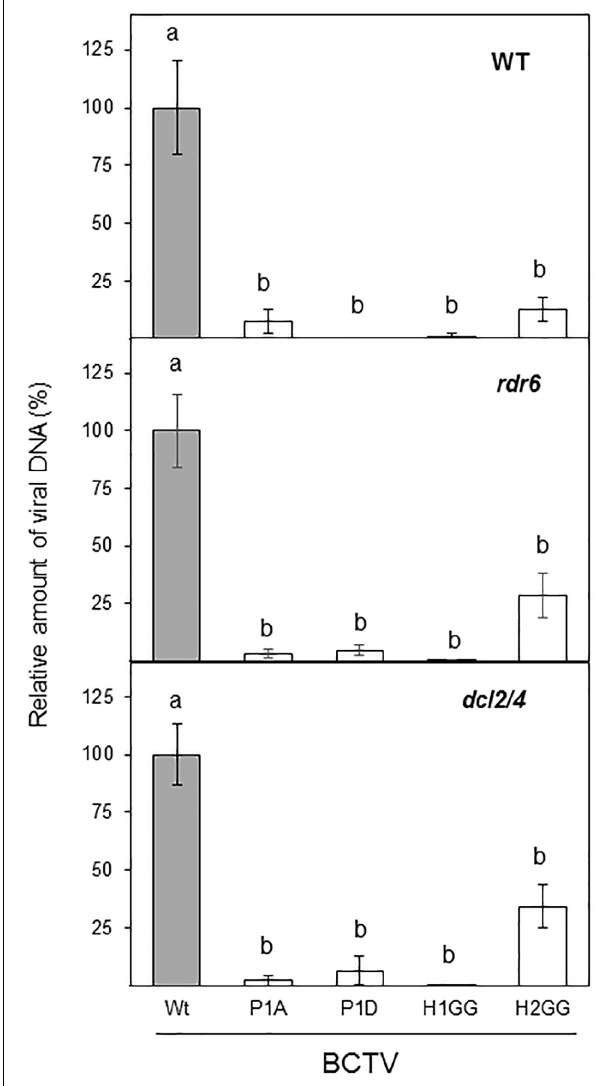
FIGURE 7 | Infection of A. thaliana wild-type (WT), dcl2/4 ( dcl2-1/dcl4-2 ) and rdr6 (rdr6-15) mutants with wild-type or BCTV V2 mutants. The relative viral DNA accumulation at 28 dpi was quantified by qPCR in WT, rdr6 and dcl2/4 backgrounds. DNA levels were normalized to actin gene and are presented as the relative amount of virus compared with the amount found in wild-type BCTV (wt) samples (in gray, set to 100%). Bars represent mean values ± standard error (SE) for eight to twelve plants per biological replicate. Data from three biological replicate are shown. Mean values marked with different letter (a or b) indicate results significantly different from each other, as established by One Way ANOVA (Dunnett’s Multiple Comparison Test; P <